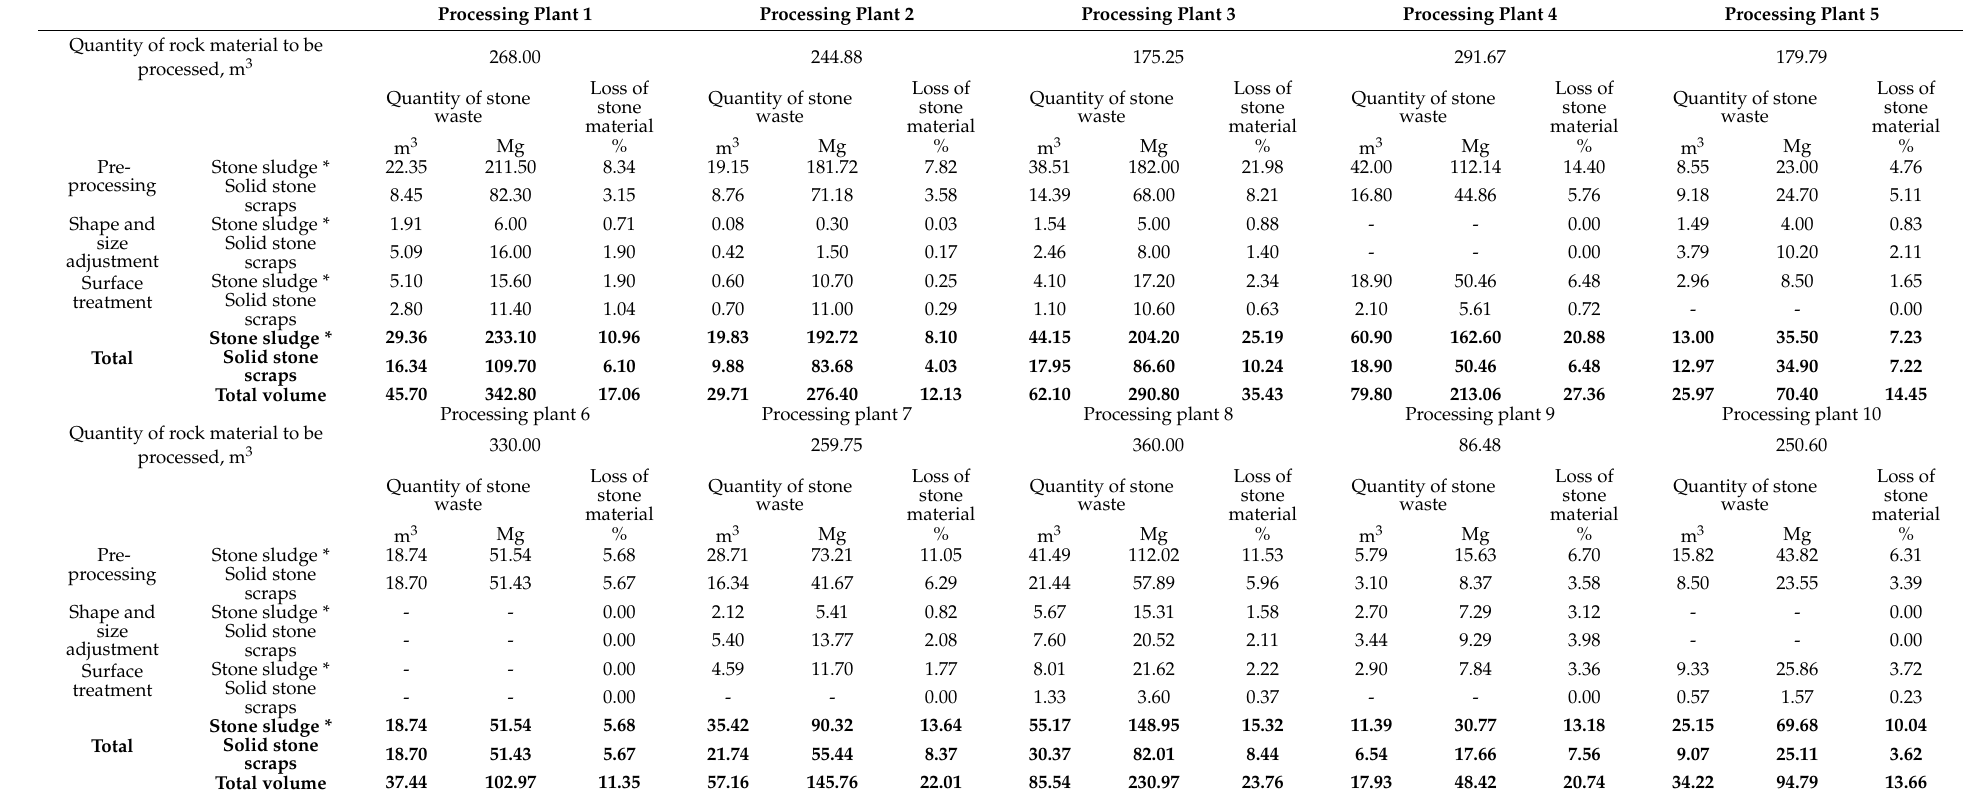
Table 3. Average volume of stone waste produced per month in each of the processing